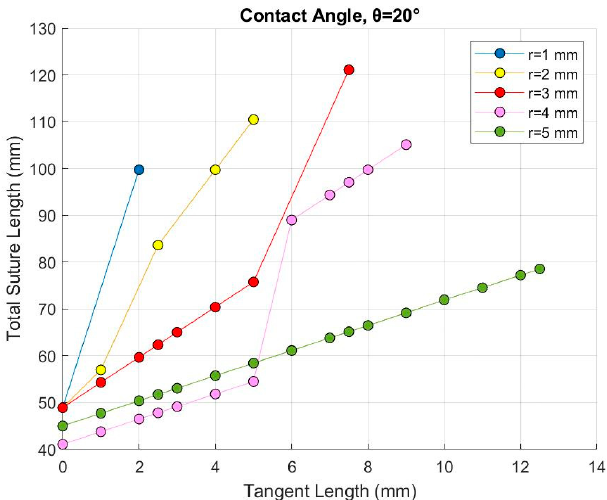
Figure 4. Representative example of the relationship between total suture length (global variable) and suture tab radius and tangent length, for a contact angle of 20° (the three local variables). While the three local variables are interchangeable (i.e., the same data can be graphed using different var- iables on the x-axis), plotting tangent length on the x-axis is the easiest to interpret, since L has the largest range of